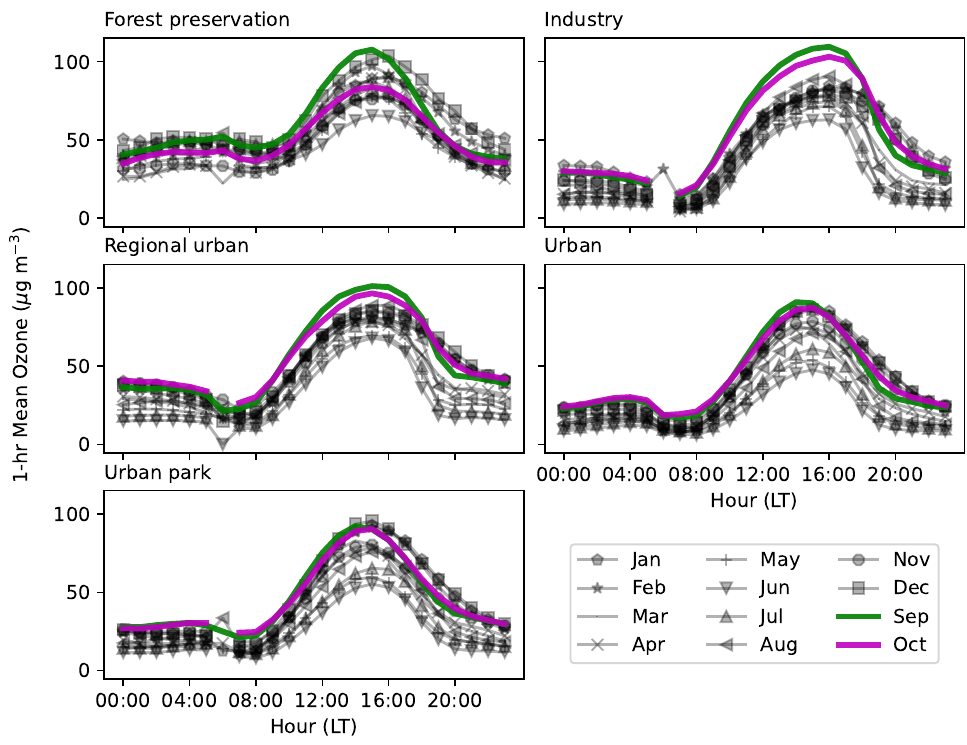
Figure 3. Daily profile analysis for surface ozone concentrations by station types and